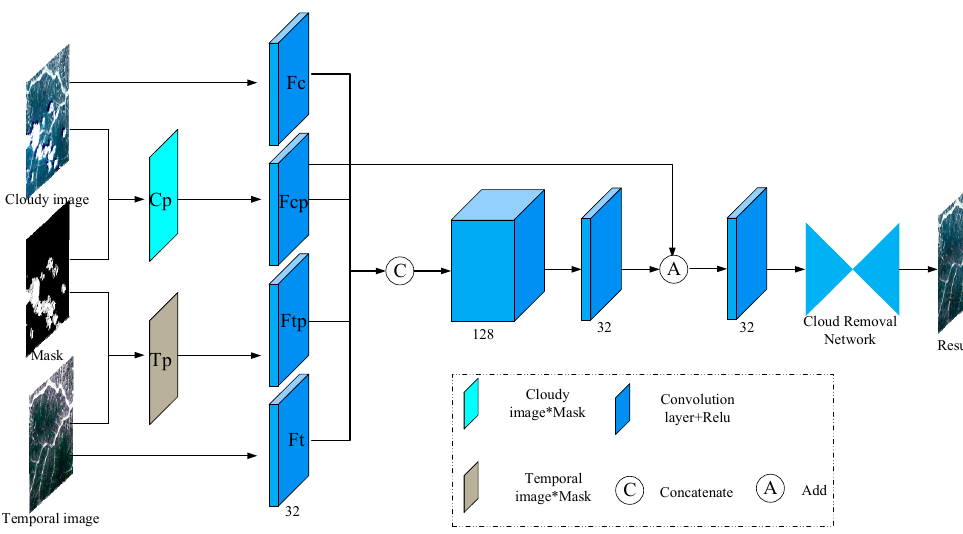
Figure 1. The overall framework. Cp and Tp are results of the bi-temporal images being multiplied by the cloud mask map pixel-by-pixel to filter out the cloudy area. Fc, Fcp, Ftp, and Ft are features extracted from cloudy image, Cp, Tp, and temporal image with 32 3 × 3 convolution kernels, respectively.